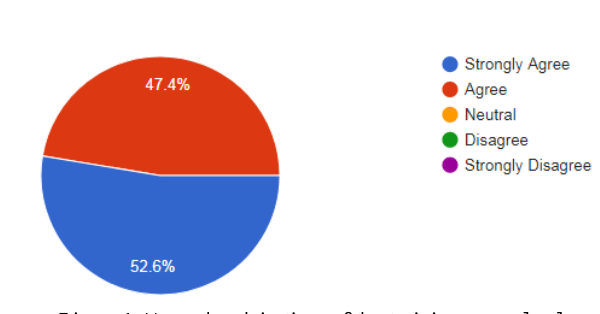
Figure 1: Were the objectives of the training were clearly Defined